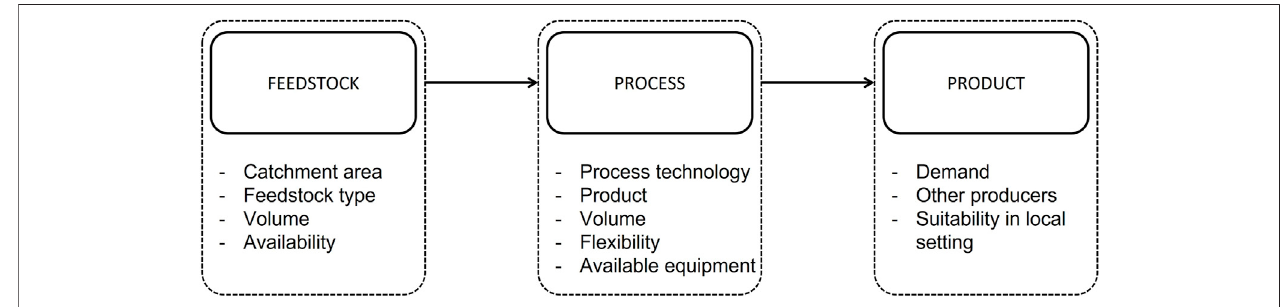
FIGURE 2 | Flowsheet representing the three biore fi nery design entry points and their accompanying main strategic design decisions.